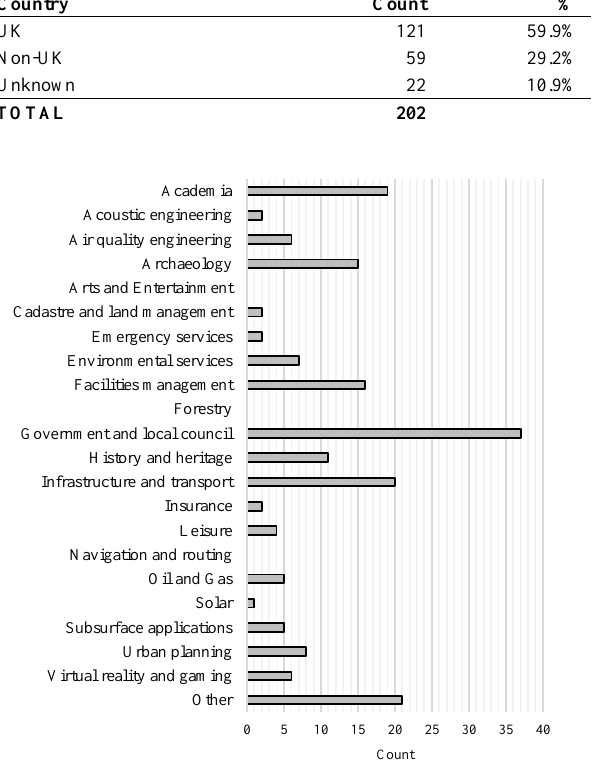
Figure 2. Which sector would you describe yourself to be in? – UK responses